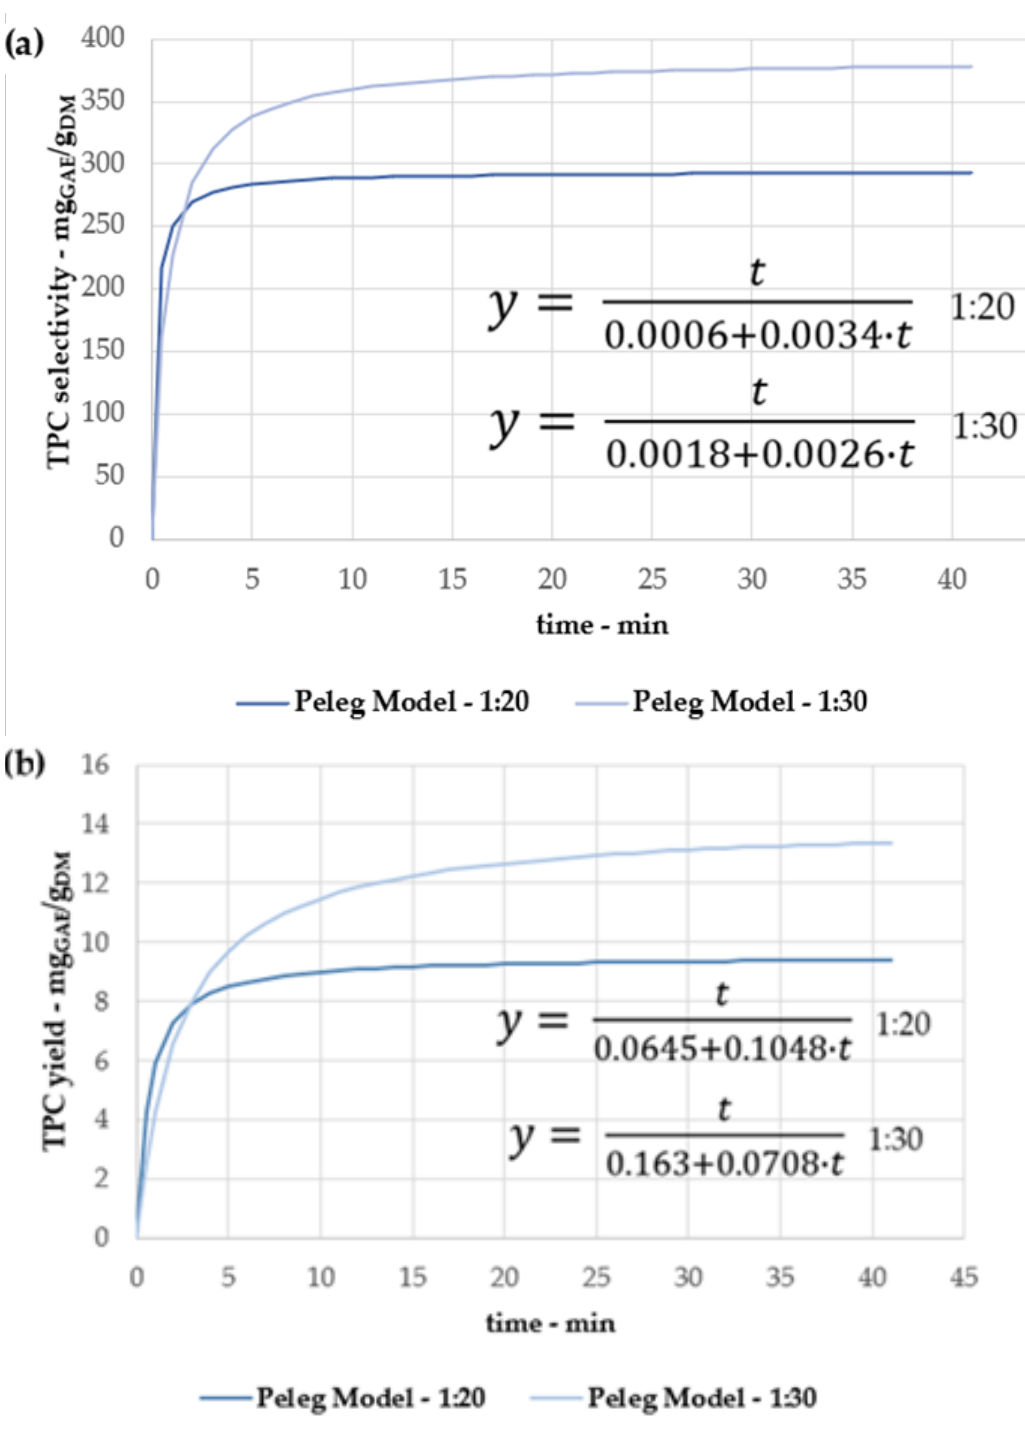
Figure 5. Peleg model for 1:20 and 1:30 S/L ratios, chestnut peel extractions at 150 °C. ( a ) TPC selectivity; ( b ) TPC yield.